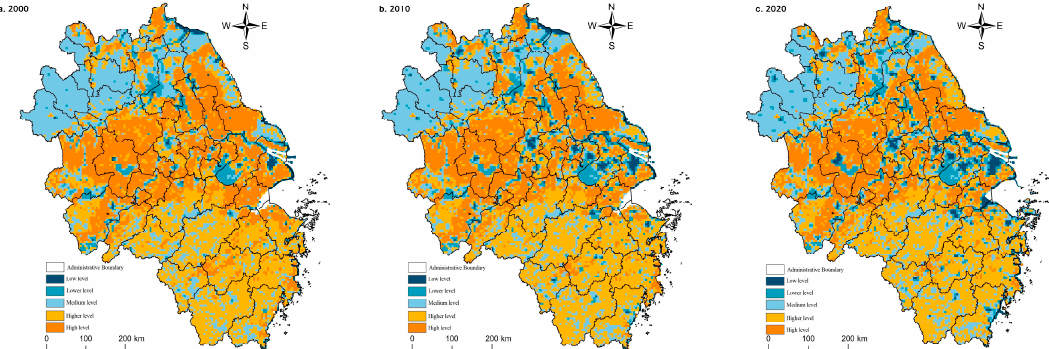
Figure 3. Spatial pattern of agricultural production functions in the Yangtze River Delta region,